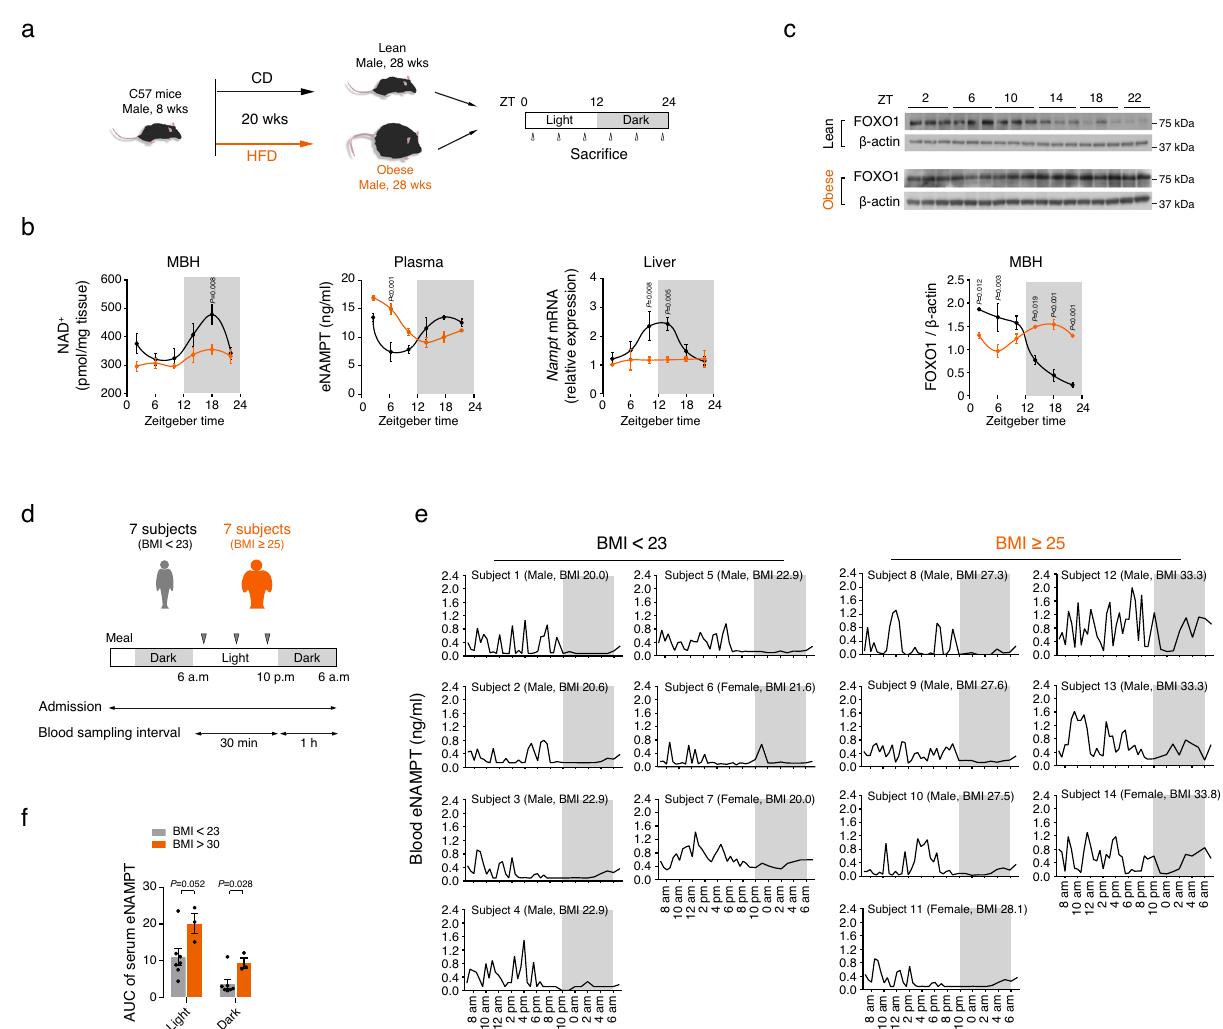
Fig. 7 | Obesity disrupts the circadian rhythms of the blood eNAMPT – hypothalamic NAD + – FOXO1 axis. a Schematic diagram of the obese mice study. b Disruptedcircadianrhythms in hypothalamic NAD + levels, plasma eNAMPT,and liver Nampt inobesemicefedahigh-fatdietfor20weeks(Lean, n =3;Obese, n =5 mice).RepeatedmeasuresANOVAfollowedbyFisher ’ sLSDtest.Twoindependent experiments were performed to validate the results. c Comparison of circadian rhythms in hypothalamic FOXO1 expression levels in lean and 20 weeks-HFD-fed obese mice (ZT22, n =2; other groups, n =3 mice). Repeated measures ANOVA followed by Fisher ’ s LSD test. Two independent experiments were performed to validate the results. Samples derive from the same experiment and that gels/blots